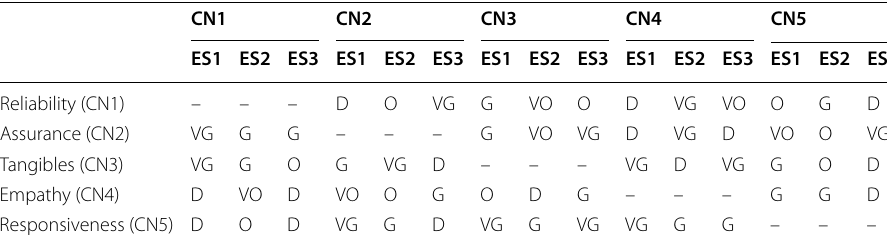
Table 14 LEs for the customer